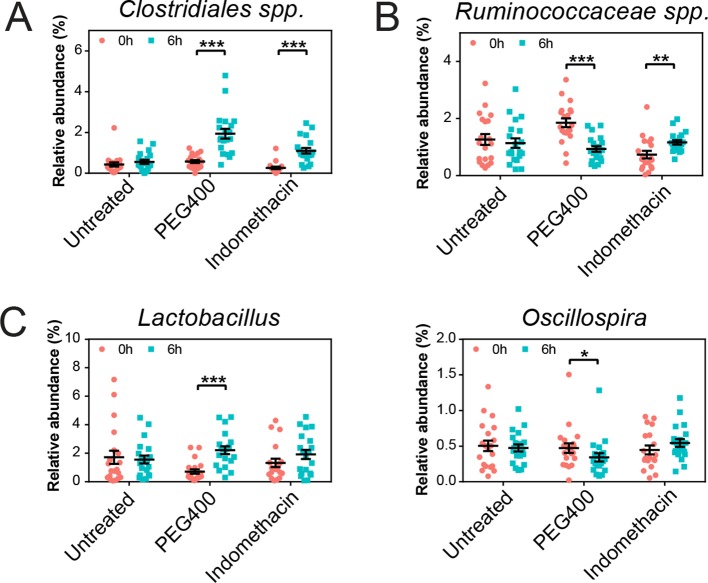
Longitudinal effects of acute indomethacin treatment in fecal microbiota composition.Microbiota composition in fecal pellets before (0 hr, black) and after (6 hr, blue) treatment with or without indomethacin or PEG400 is analyzed by 16S rRNA gene profiling. (A) The relative abundance of Clostridiales sp. is increased in both PEG400 and indomethacin groups at 6 hr. (B) The relative abundance of Ruminococcaceae sp. is decreased in the PEG400 group but increased in the indomethacin group at 6 hr. (C) PEG400 induced an increase of Lactobacillus (left) and a decrease of Oscillospira (right), whereas there is no change in the untreated or indomethacin treated groups. *p<0.05, **p<0.01, ***p<0.001 by QIIME analysis, FDR corrected. N=19–20/group. Mean ± S.E.M. shown.